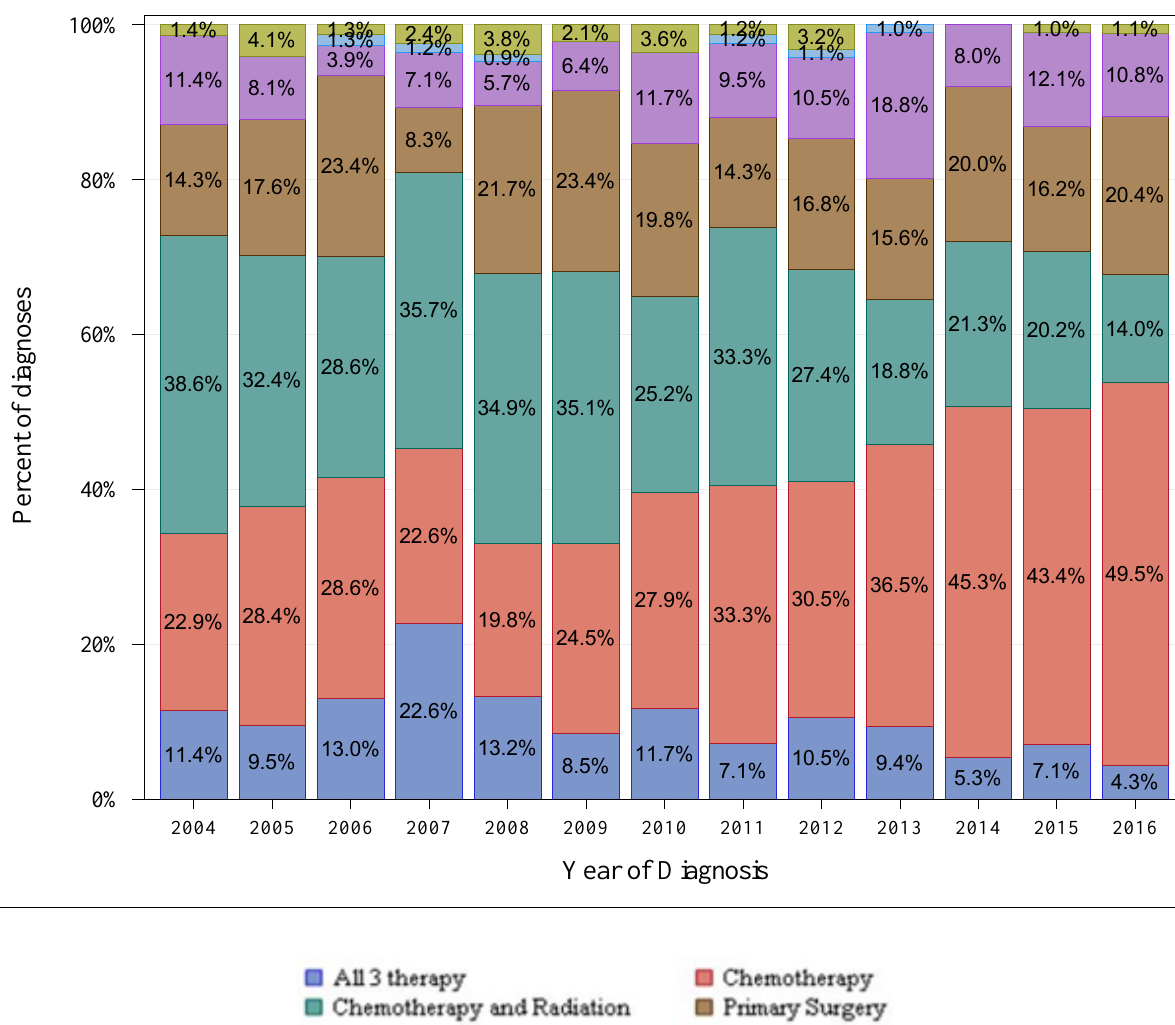
Figure 4. Differences in SEER-18 Regional Stage by Types of Therapy (Excluding pNET), 2004 – 2016, Ages < 50.